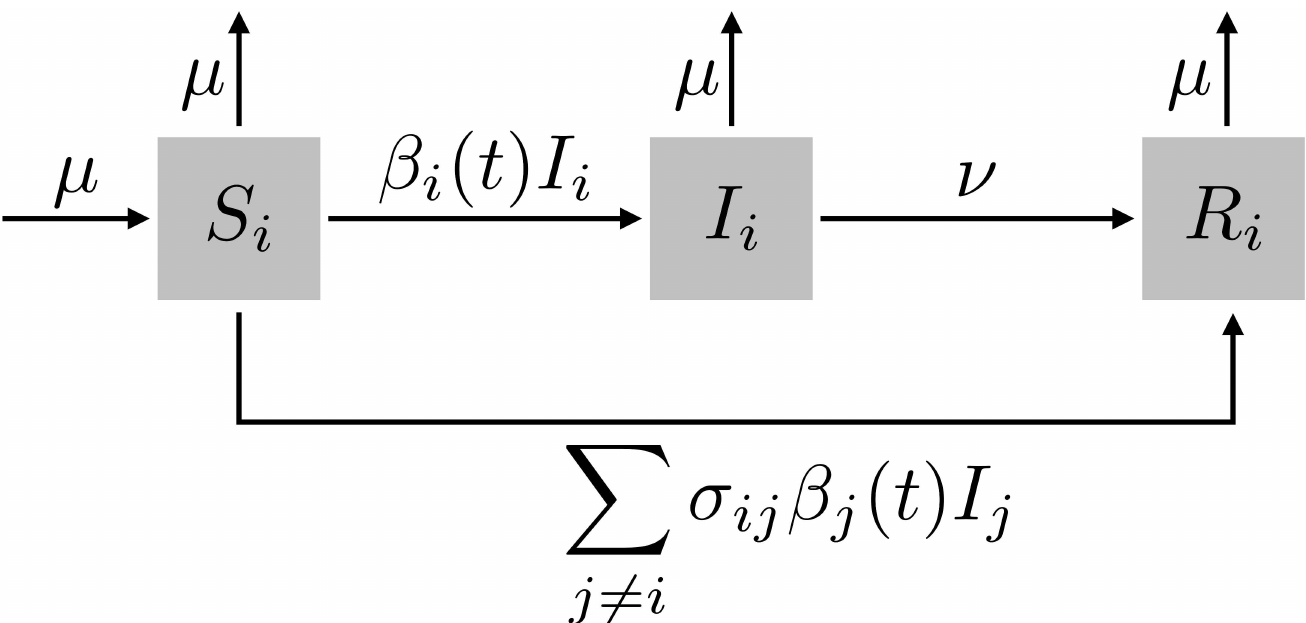
Fig 7. Compartmental representation of strain-competition model. Hosts are susceptible(S), infected/infective (I), or recovered(R) with respect to each strain. Hosts move from S to I based on a seasonally varying transmission rate, and from I to R at a constant recovery rate. Competitiontakes place through cross-immunity, which is implemented by havinghosts skip the infected state for one strain with some probabilityif they are already infected with another strain.